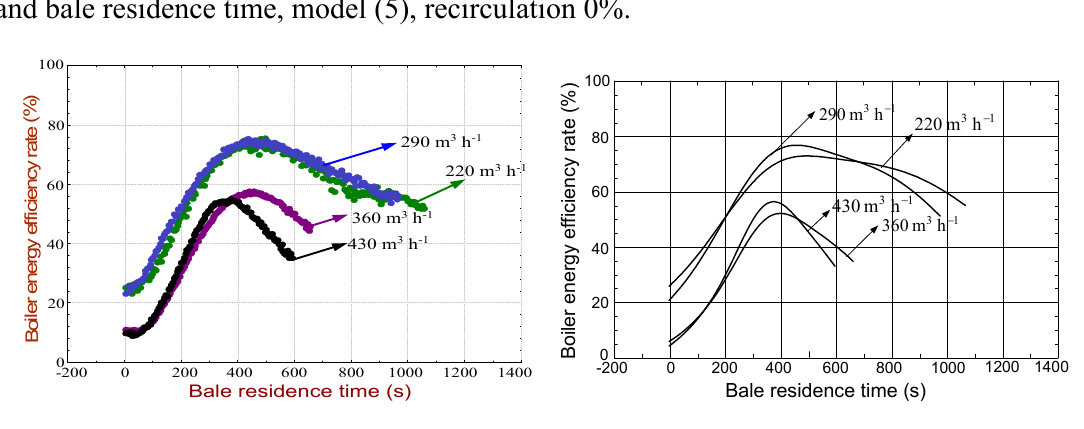
Figure 10. Correlation between boiler energy efficiency rate and bale residence time, model (6), recirculation